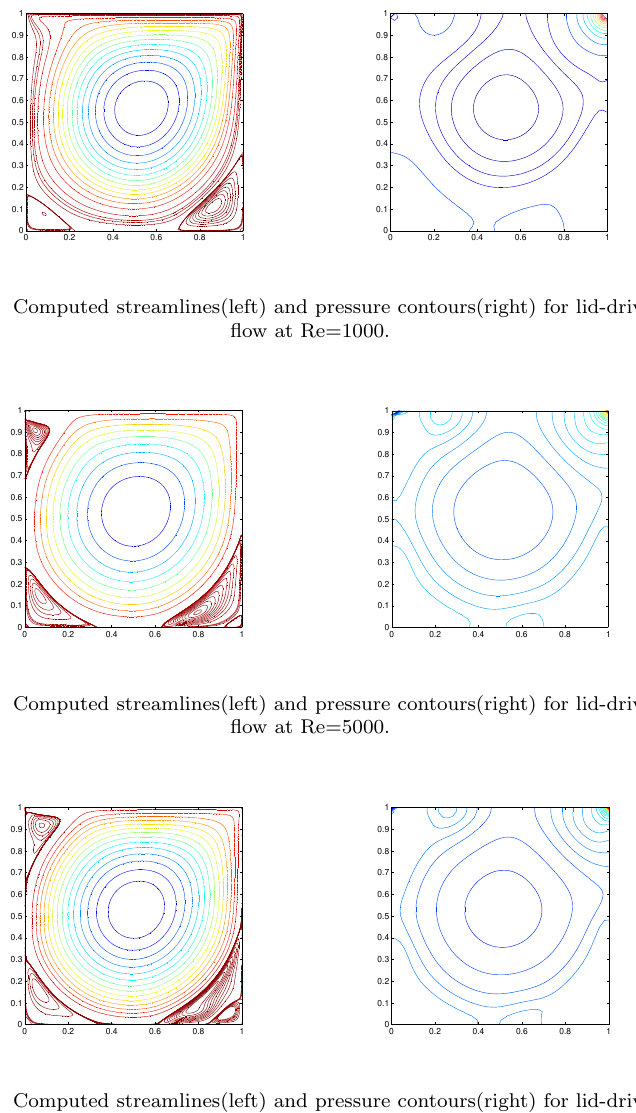
Figure 5. Computed streamlines(left) and pressure contours(right) for lid-driven cavity flow at Re=10000. tion are still somewhat different from the real blood flow parameters, but